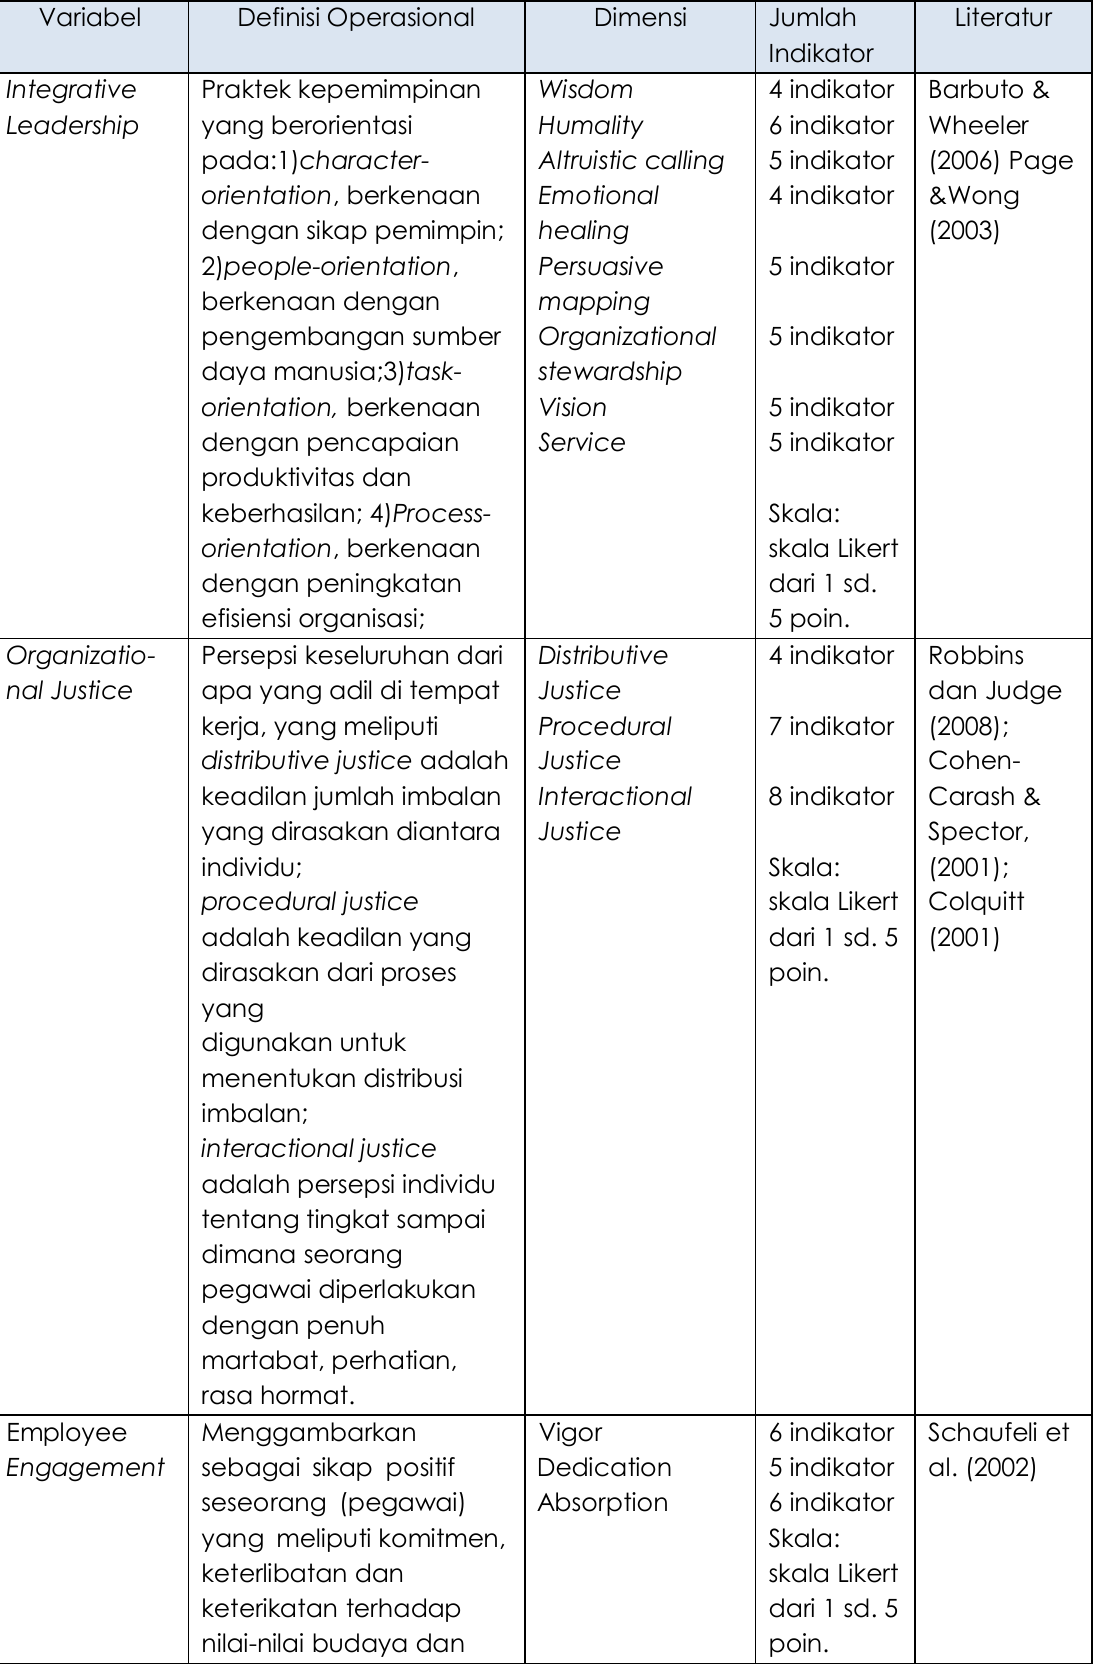
Tabel 1. Pengukuran dan definisi operasional variabel